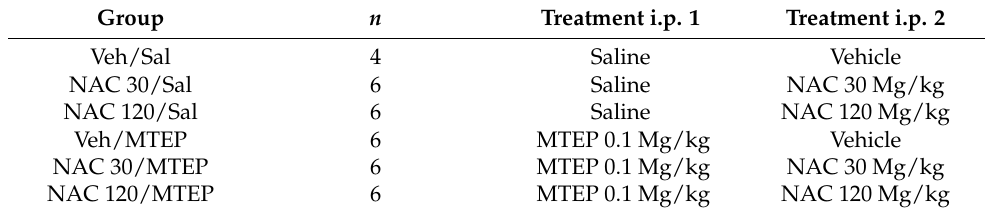
Table 1. i.p. treatments in each experimental group of experiment 2. Group